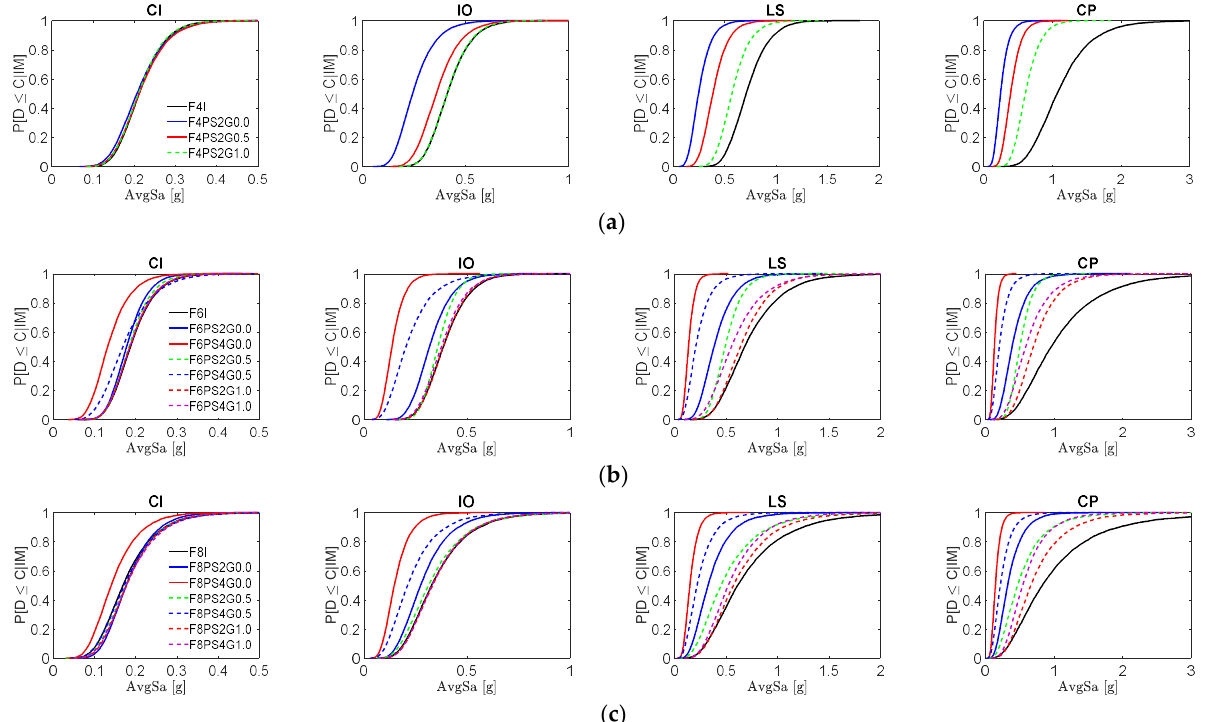
Figure 22. Fragility functions for different structures involving floor-to-column pounding and different values of the seismic separation distance ratio when the left-hand side structure is a 4-storey ( a ), 6-storey ( b ) and an 8-storey ( c ) building.